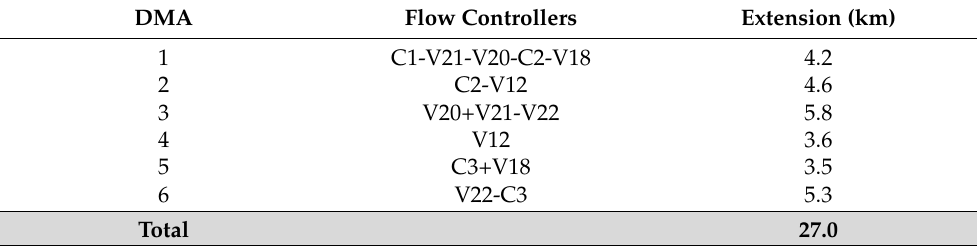
Table 5. Characterization of the district-metered areas.